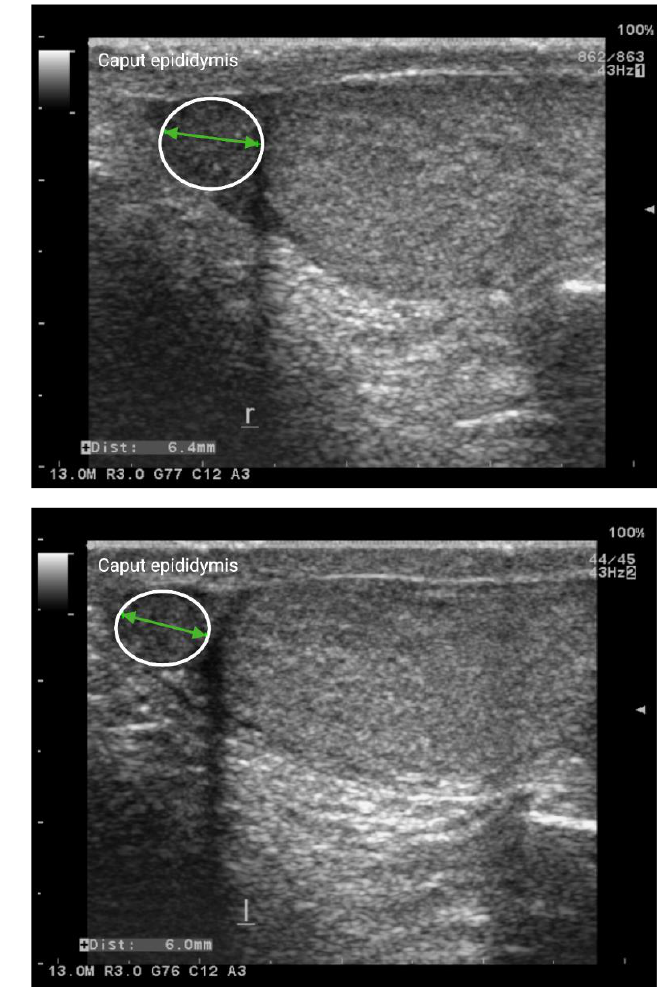
Figure 1. Use of scrotal ultrasound to diagnose obstructive azoospermia. On the left side, a schematic diagram illustrating the hypothesized dilatation in caput epididymis due to obstruction in the male genital tract. The craniocaudal diameter of caput epididymis is determined and normalized to the ipsilateral testicular volume (calculated by the formula radius 1 × radius 2 × radius 3 × 4/3 × π, where radii 1, 2, and 3 are the different axial radii of testis determined by ultrasonic imaging). On the right side, the upper figure shows an example for a scrotal ultrasound image for an adult infantile cystinosis patient, illustrating a dilated caput epididymis. The lower figure shows an example for a scrotal ultrasound image for an adult healthy male, with no signs of dilated caput epididymis [20] . Green arrows in the two ultrasound images represent the craniocaudal diameter of caput epididymis (6.4 mm in upper panel figure; 6.0 mm in lower panel figure).